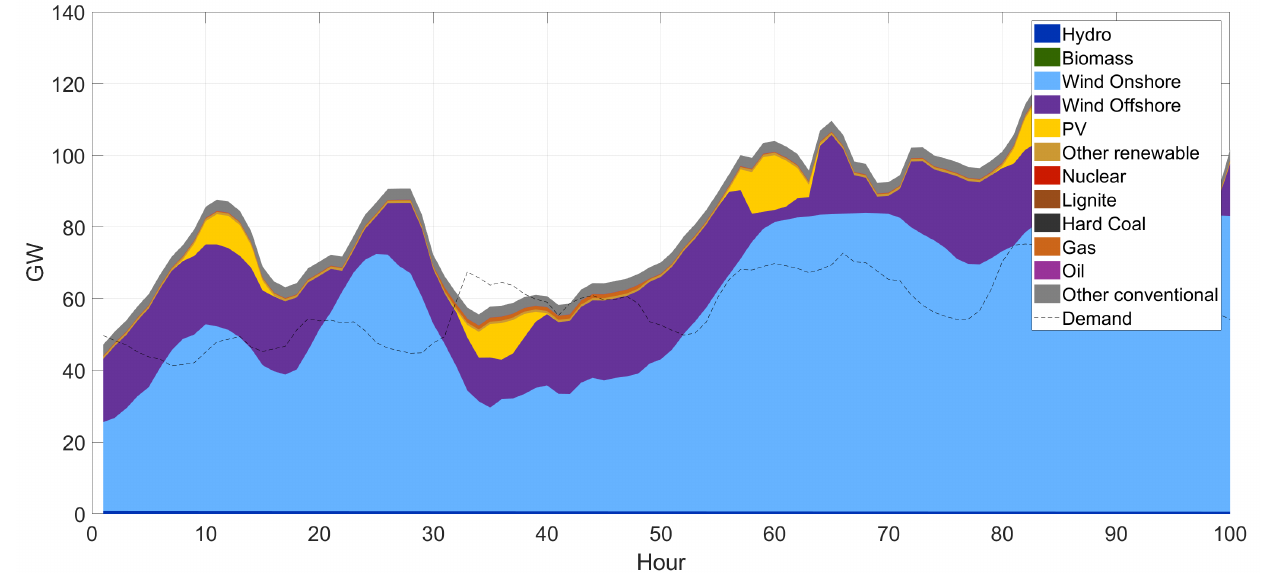
Figure 15. Generation and demand in Germany.